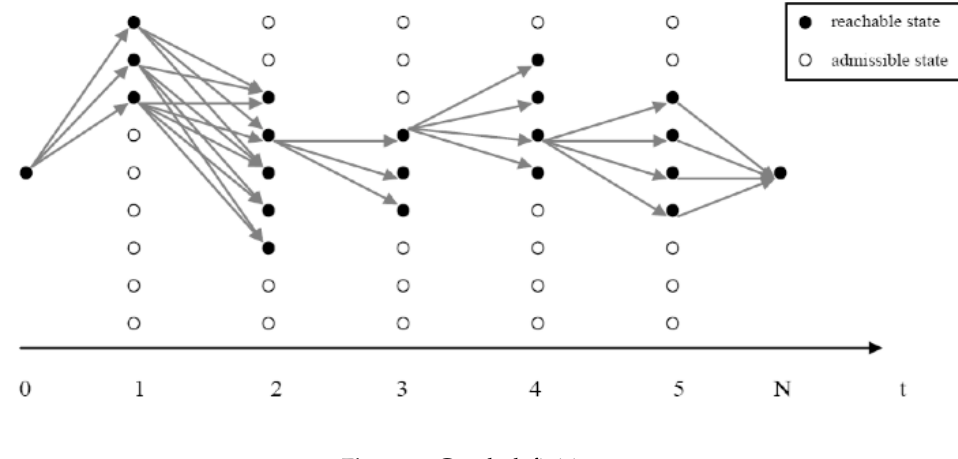
Figure 5. Graph definition.